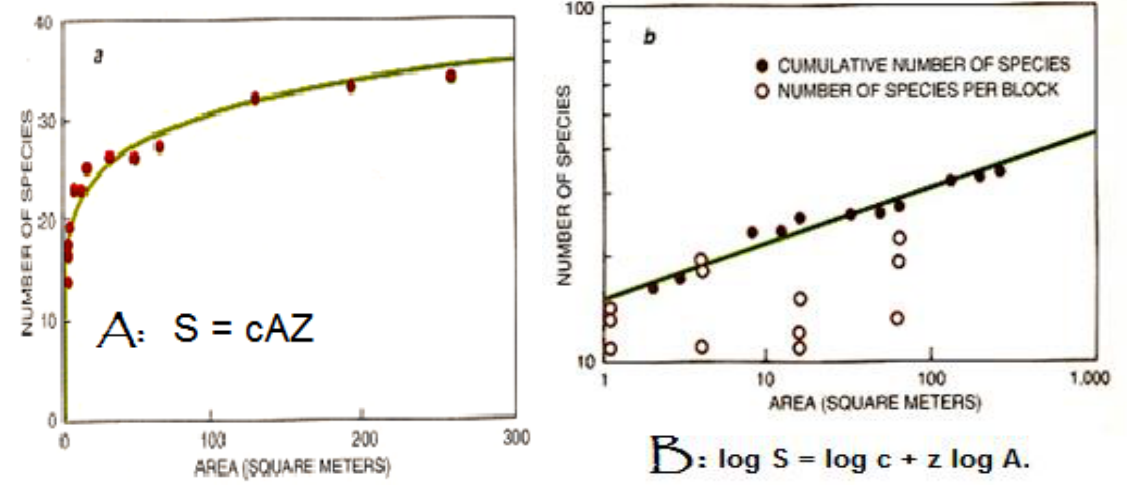
Figure 1: Species Area Curve